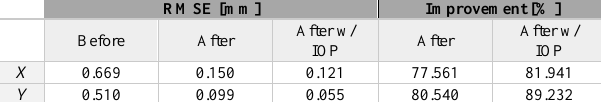
Figure 8: Histogram of the y-image residuals in fluoroscopic system 2